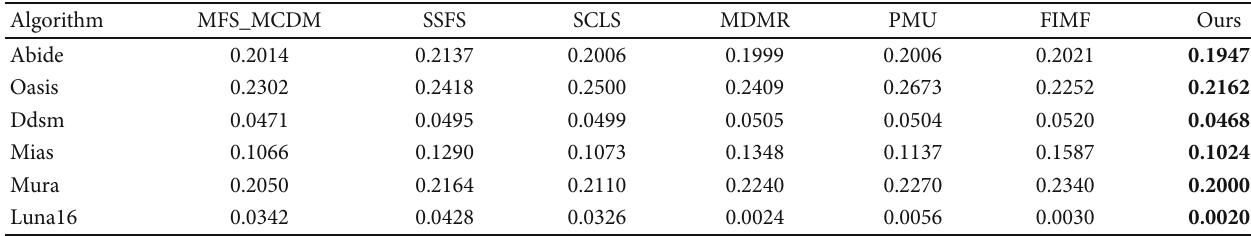
Table 3: Display of optimal experimental results under index hamming